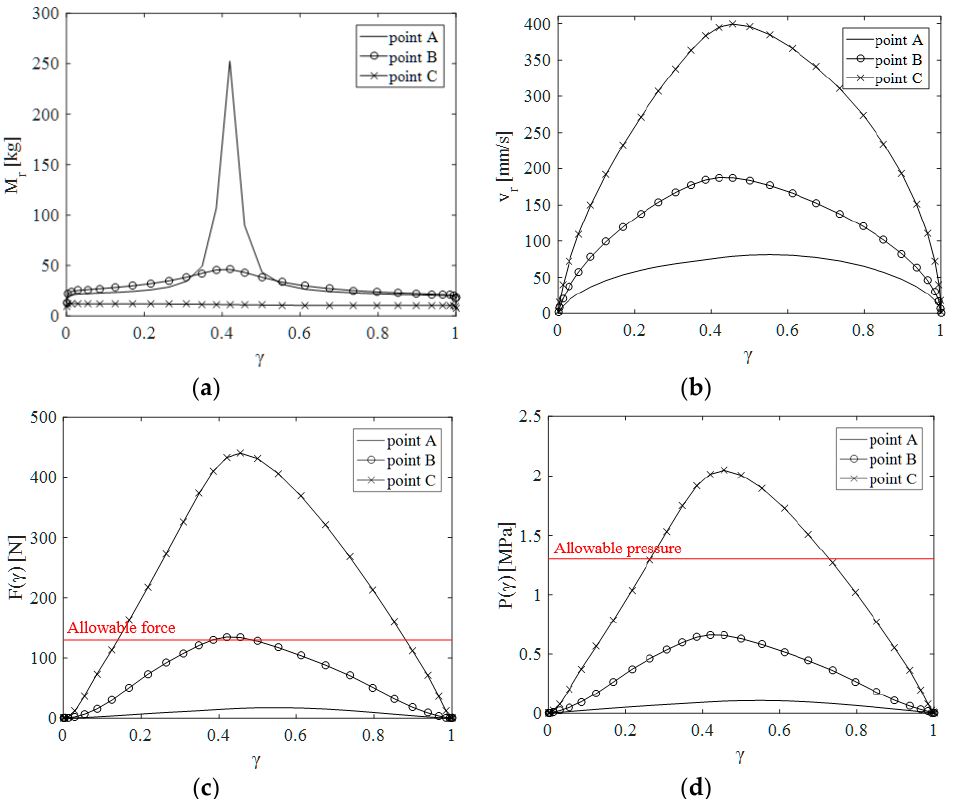
Figure 6. Simulation results for evaluation collision safety of UR5 robot: ( a ) effective mass, ( b ) normal direction velocity to contact surface, ( c ) estimated collision force, ( d ) estimated collision pressure.